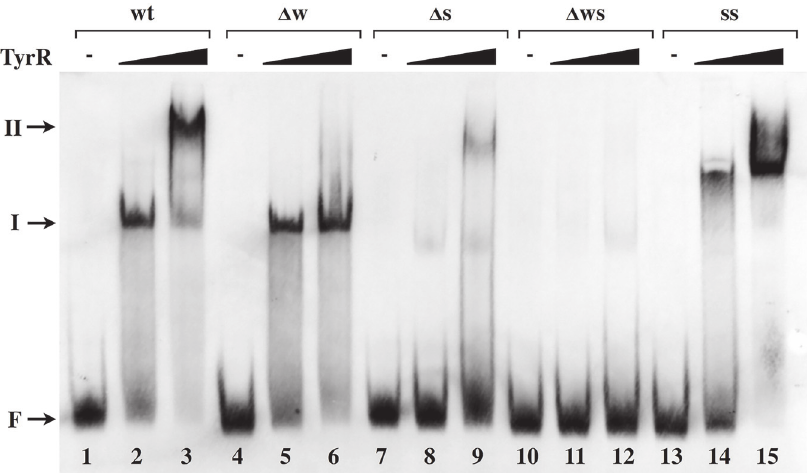
Fig 4. Binding of TyrR to the TyrR boxes within the akr-ipdC intergenic region. DIG-labeled DNA probes correspond to the akr-ipdC intergenic sequence of the template plasmid from which they were